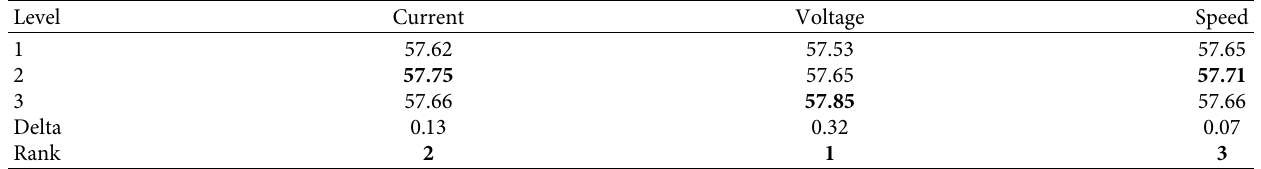
Table 15: Response table for S/N ratio of tensile strength (the larger the better).